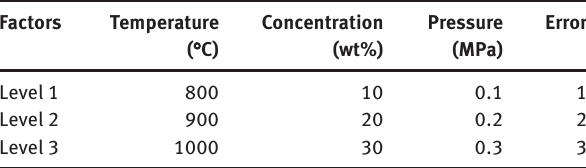
Table 1: Four factors and their corresponding levels in the study.